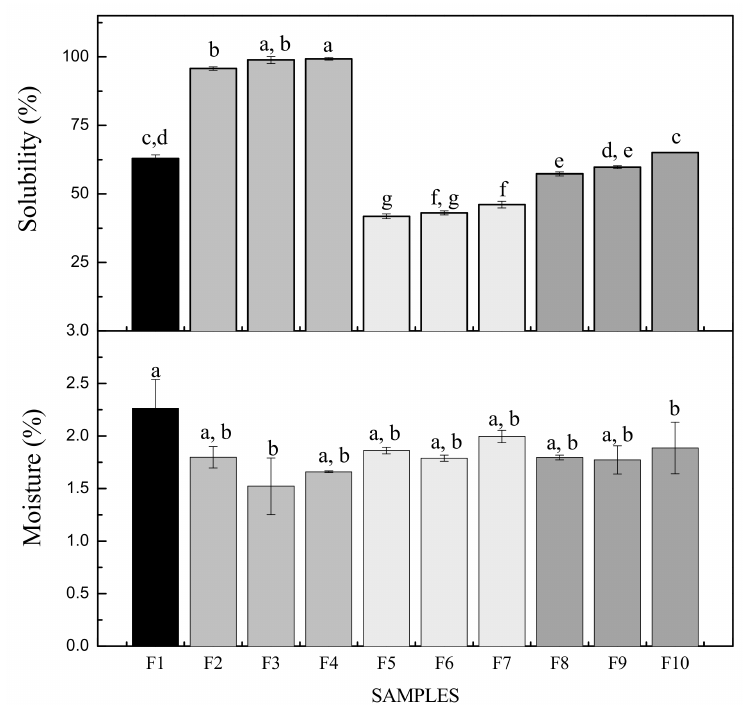
Figure 4. Solubility and moisture content of the reinforced gelatin biofilms. Different letters indi- cate statistically significant differences ( p < 0.05) among the biofilms ( n = 3). F1: control sample; F2–F4: samples with microfiber; F5–F7: samples with bentonite; F8–F10: samples with microfiber and